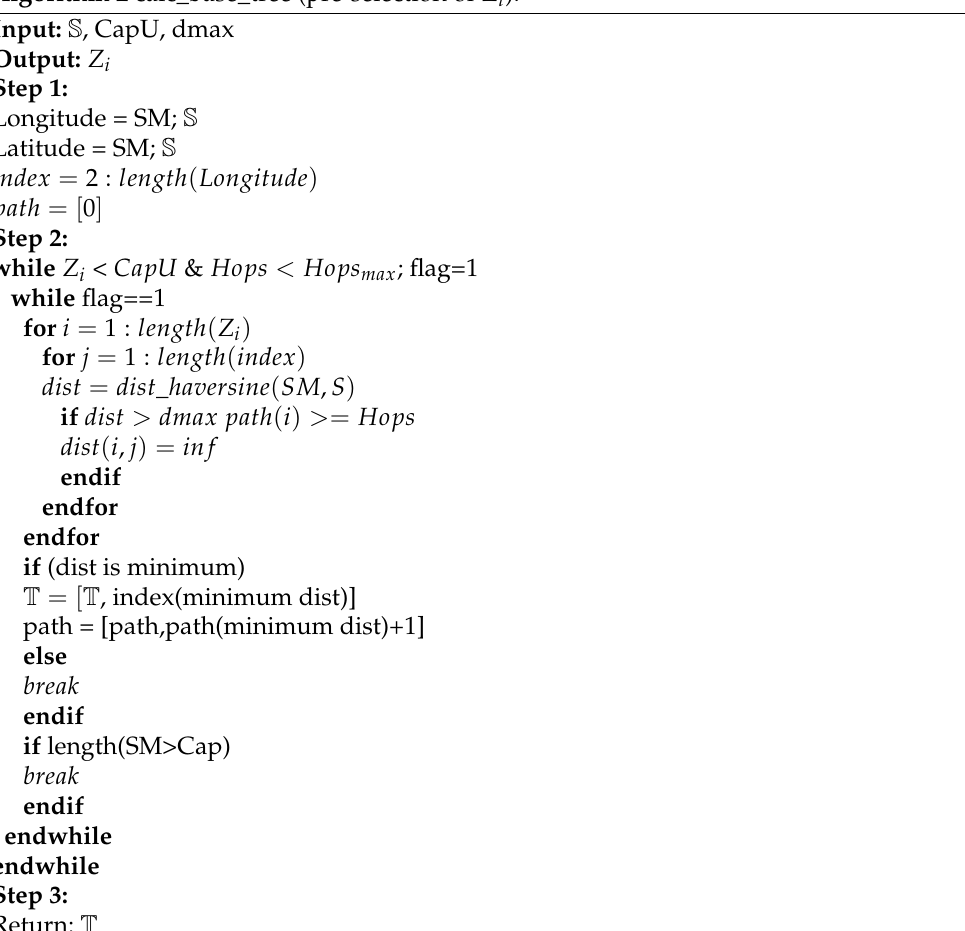
Algorithm 2 calc_base_tree (pre-selection of Z i